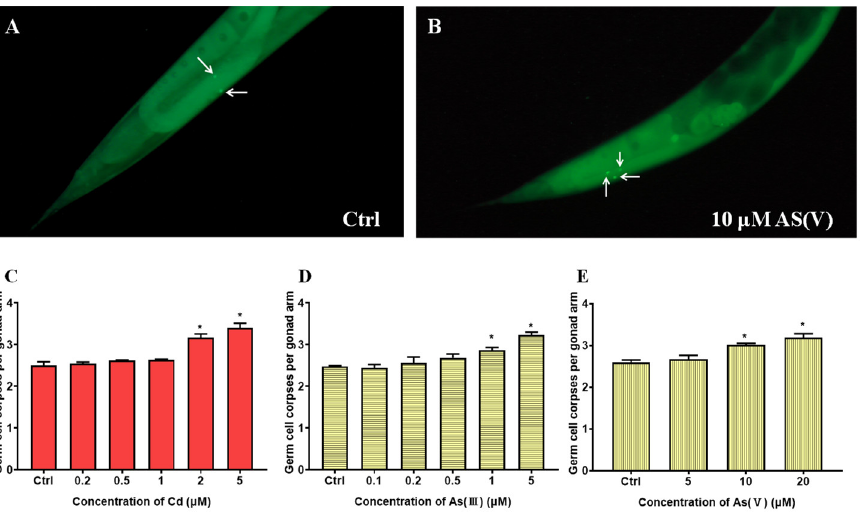
Figure 1. Images of AO stained apoptotic cells in the gonads ( A , B ) and the determination of non-toxic concentrations of ( C ) Cd, ( D ) As(III), and ( E ) As(V) based on germ cell apoptosis. * means p < 0.05. A